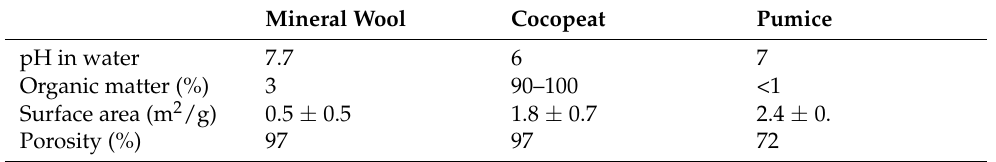
Table A1. Physicochemical characteristics of the substrata [15].